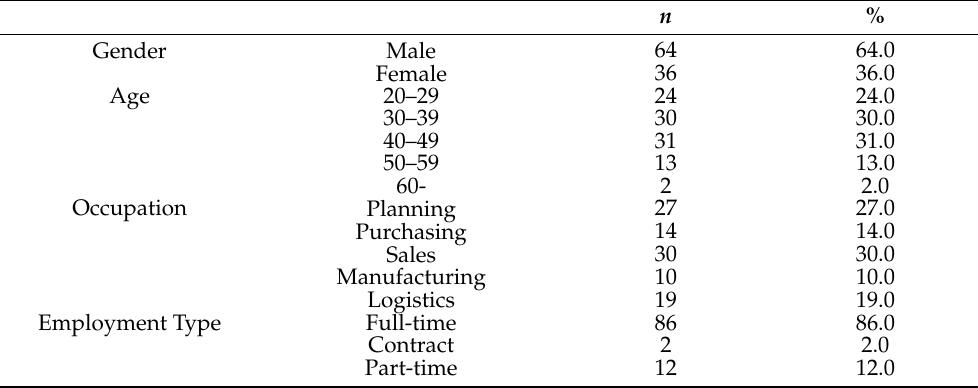
Table 1. Study participants ( n =